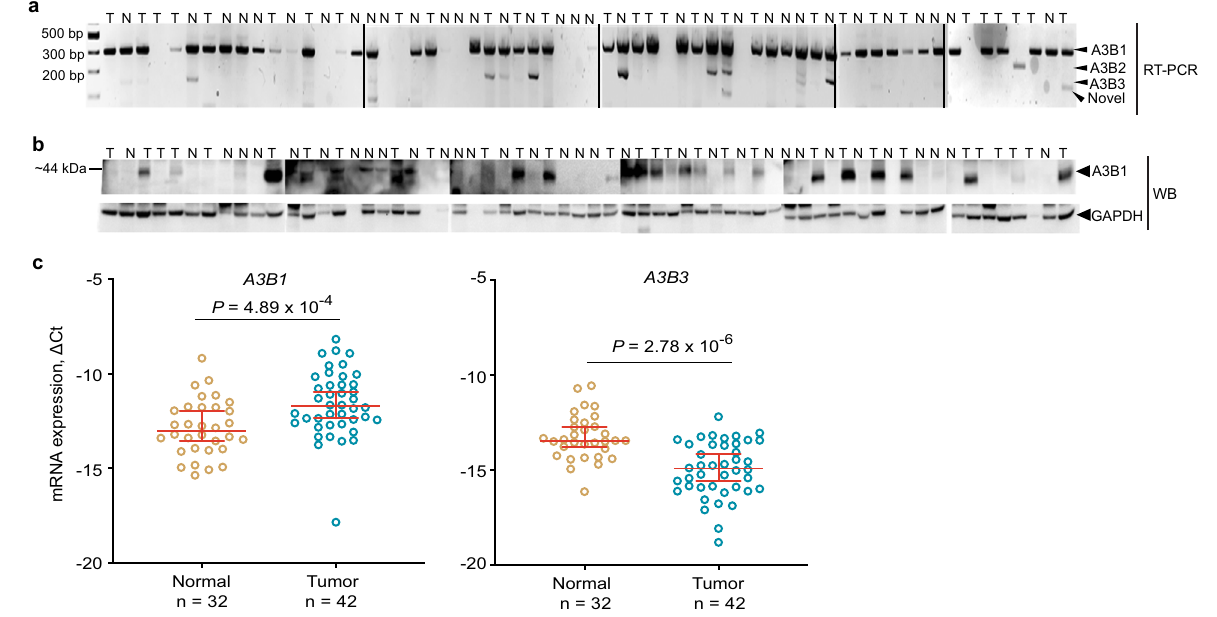
Fig. 4 Analysis of A3B alternative splicing in paired tumor and adjacent normal samples. a RT-PCR analysis in 63 bladder tissue samples. Sanger sequencing of RT-PCR products generated with primers for A3B exons 4 and 6 shows the canonical ( A3B1 ) and alternative ( A3B2 and A3B3 ) splicing events. A splicing event (labeled as “ Novel ” ) that involves both exon 5 skipping and the use of a cryptic splice site in exon 6, was detected in three samples. An AS event (mainly A3B3 ) was observed in 19% of all samples (13 of 63 samples), including 13% of tumors (4 of 30) and 27% of adjacent normal tissues (9 of 33). b Western blot analysis for the A3B1 protein. c qRT – PCR analysis for A3B1 and A3B3 isoforms. mRNA expression levels of A3B1 were signi fi cantly higher in tumors and of A3B3 — in adjacent normal tissues. A3B2 expression was not detected in >95% samples (Supplementary Data 1). Plots show all individual data points with error bars representing 95% con fi dence intervals for the medians. P -values are for the non-parametric Mann – Whitney U